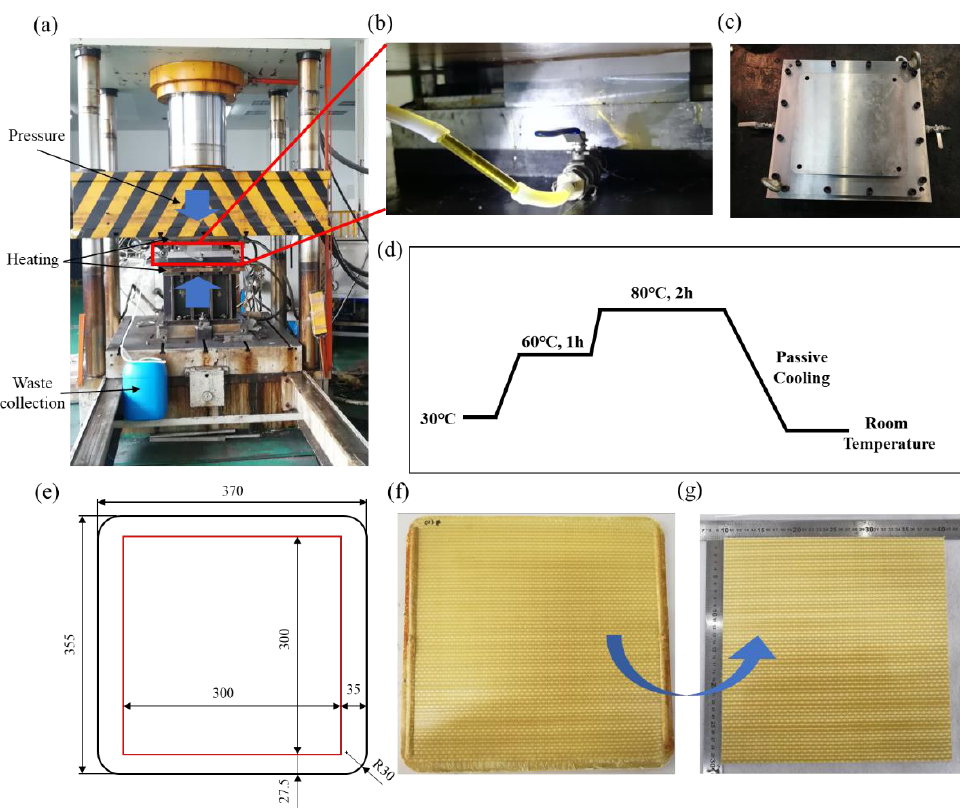
Table 3. Specifications of 3DWCs.